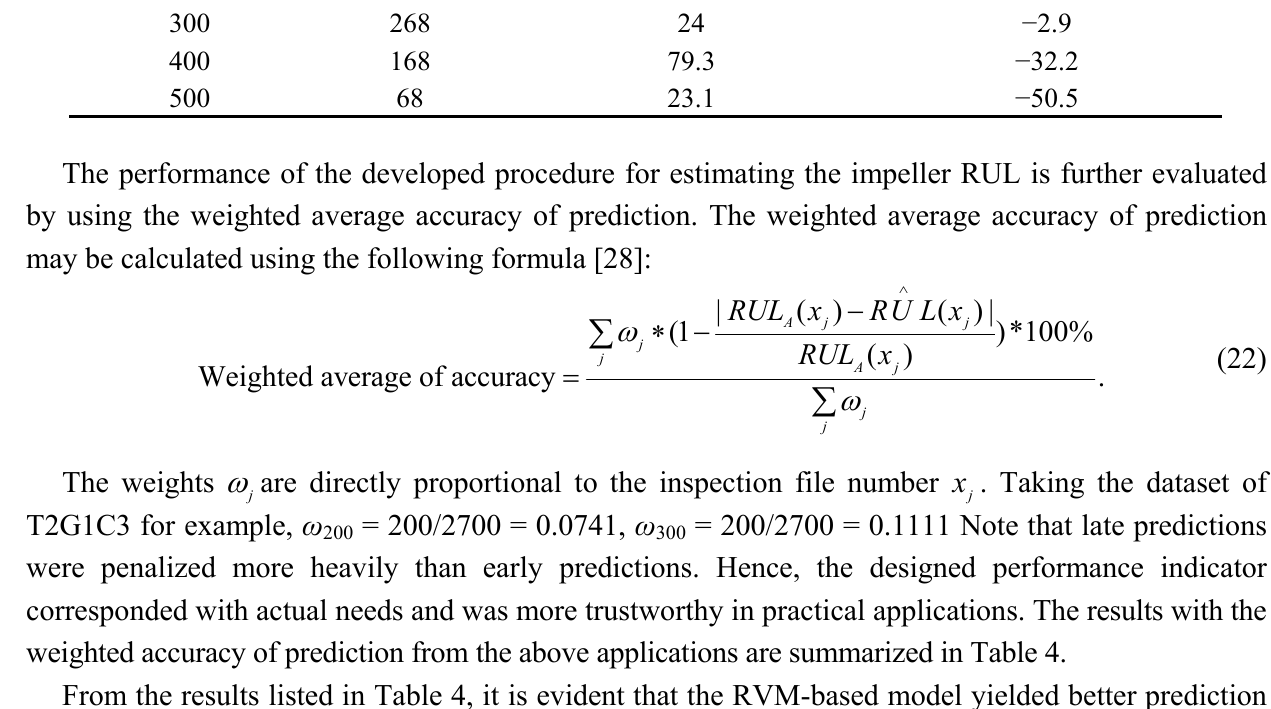
Table 3. Values of ( )